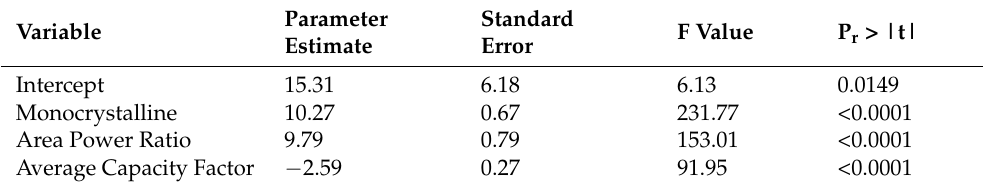
Table 4. Analysis of variance for the optimal regression model (R2 of 0.817) for estimating the global warming potential of solar